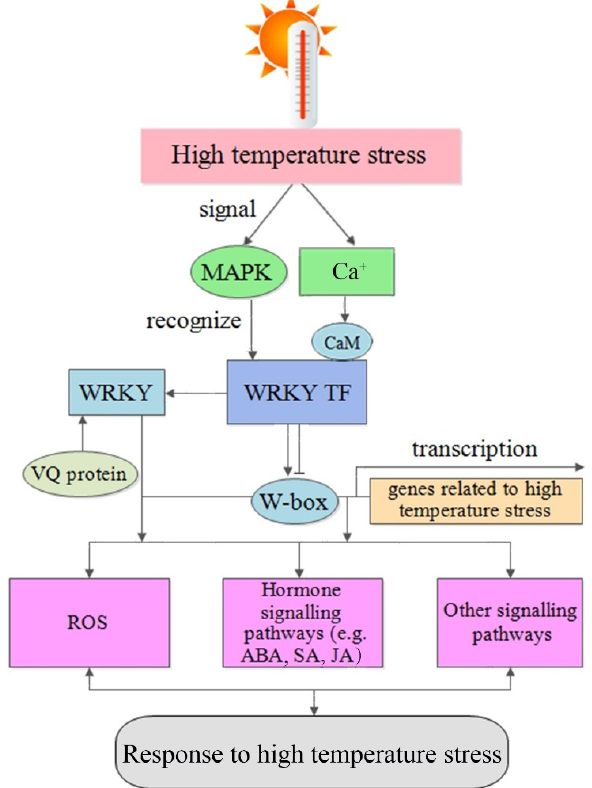
Figure 3. Model of WRKY TF responses to high-temperature stress in plants. The signaling pathway of plant WRKY TF responses to high-temperature stress is summarized. High-temperature environmental signals can trigger the activation of the MAPK signaling cascade and induce WRKY TFs to interact with target genes and related proteins. In addition, the signal can also promote an increase in intracellular Ca 2+ levels, promote the binding of CaM to specific WRKY proteins, and change the transcriptional regulatory activity of WRKY proteins. Finally, the activation of the response to high-temperature stress occurs through ROS, hormones or other signaling pathways.